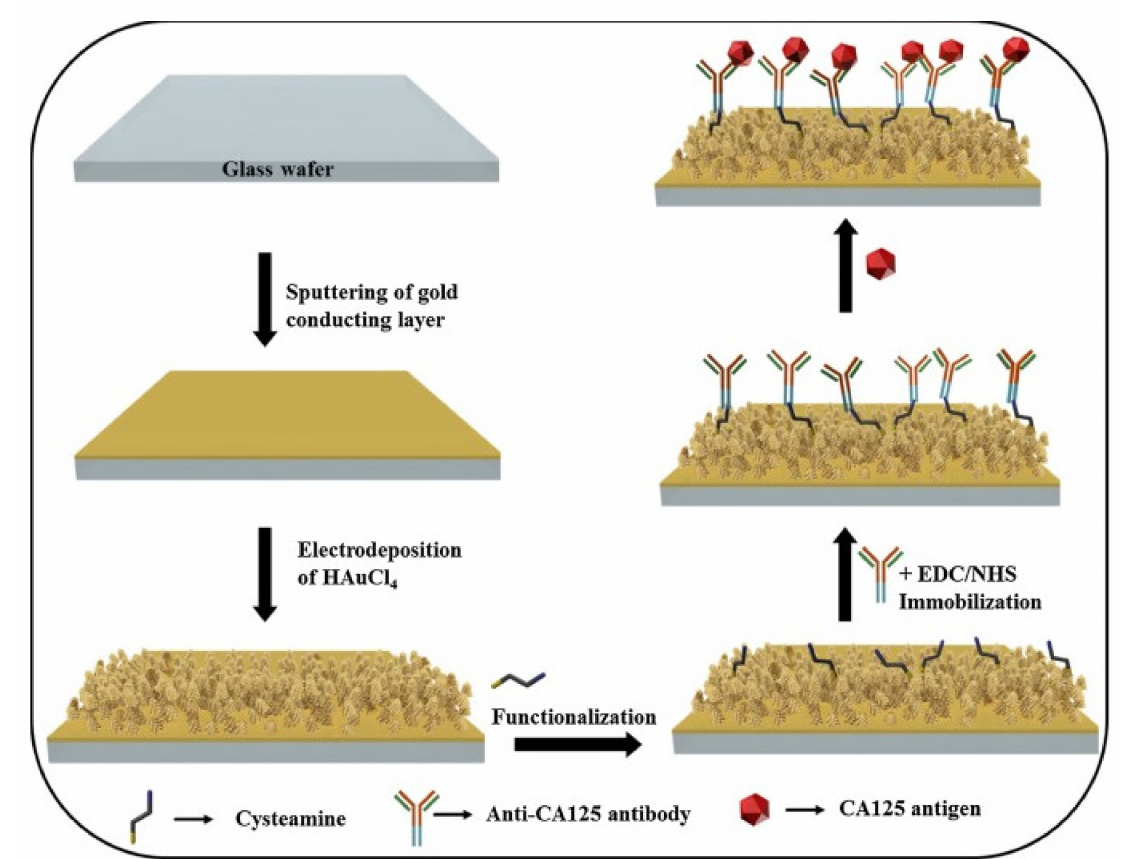
Figure 9. Step–by–step fabrication of electrochemical immunosensor. Reprinted with permission from [89], published by Elsevier,